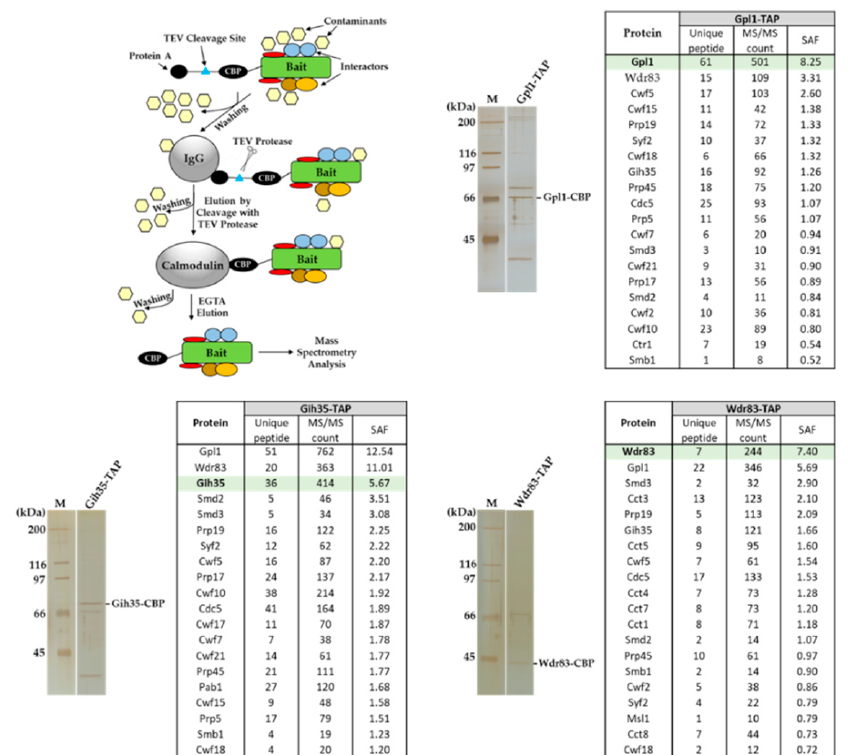
Figure 1. Identification of proteins co-purifying with Gpl1-TAP, Gih35-TAP and Wdr83-TAP proteins. Proteins associated with Gpl1, Gih35 and Wdr83 were isolated from cycling S. pombe cells by tandem affinity purification, separated by SDS-PAGE, visualized by silver staining and analyzed by mass spectrometry. Selected TOP20 interactors sorted according to their SAF (spectral abundance factor) are presented here. For a full list of co-purified proteins, see Table